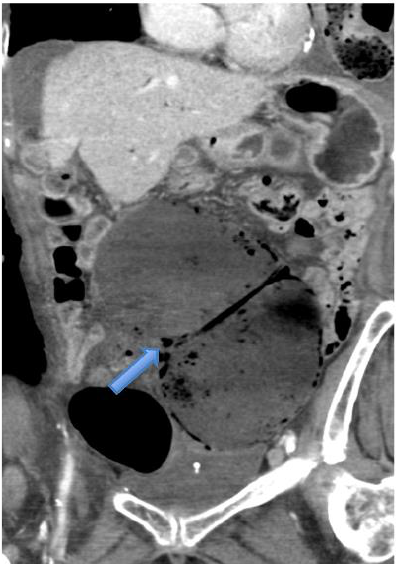
Figure 9. CT coronal image demonstrating the split-wall sign (blue arrow) which refers to the mesenteric fat in between the bowel walls.